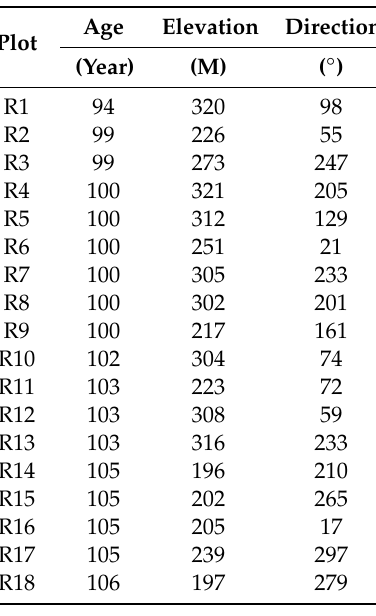
Table A1. Topographical characteristics and tree heights of